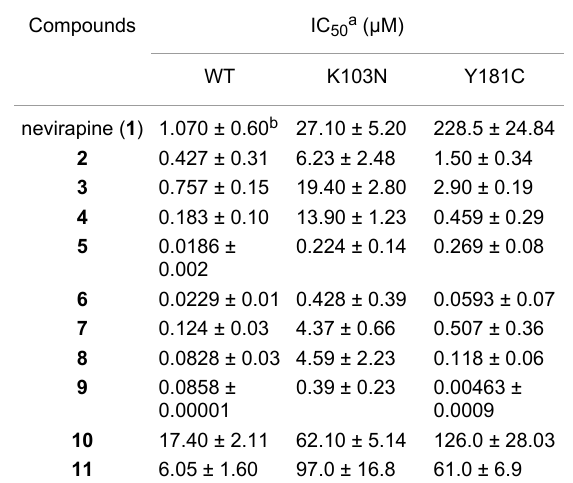
Table 1: Inhibitory activity of the synthesized compounds against HIV- 1 reverse transcriptase. Compounds IC 50a (μM)